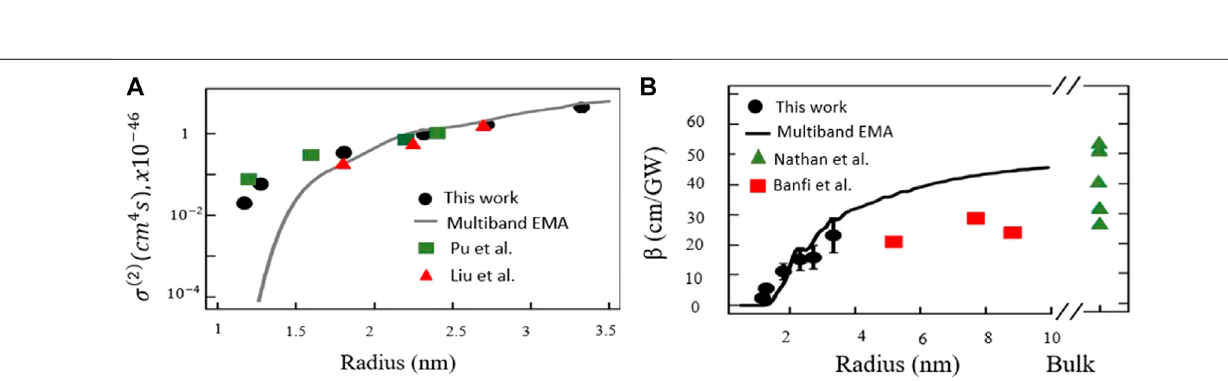
FIGURE10| Nonlinearabsorptioncoef fi cientvariationasafunction: (A) shellthicknessand (B) QDsize[128]. “ RepublishedwithpermissionoftheRoyalSocietyof Chemistry, from Ref. [128], copyright 2020; permission conveyed through Copyright Clearance Center, Inc. ”